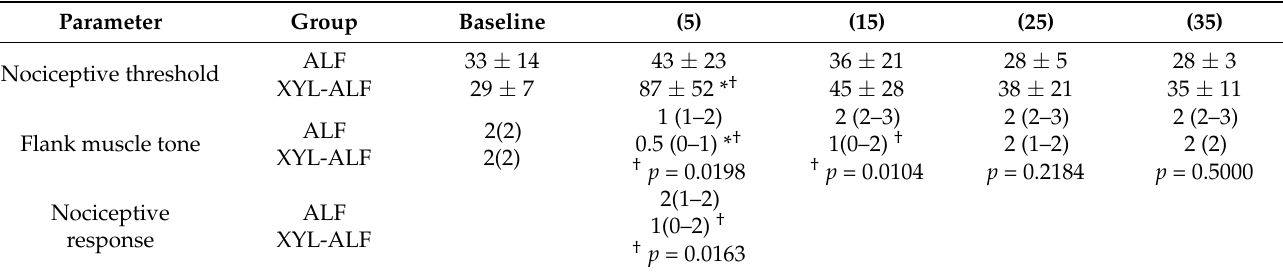
Table 4. Nociceptive threshold variables and flank muscle tone scores measured in goats at baseline and at 5, 15, 25 and 35 min after alfaxalone administration in the ALF group (4.0 ± 0.30 mg/kg bw; IV) (n = 6) and the XYL-ALF group (2.3 ± 0.25 mg/kg bw; IV) (n =